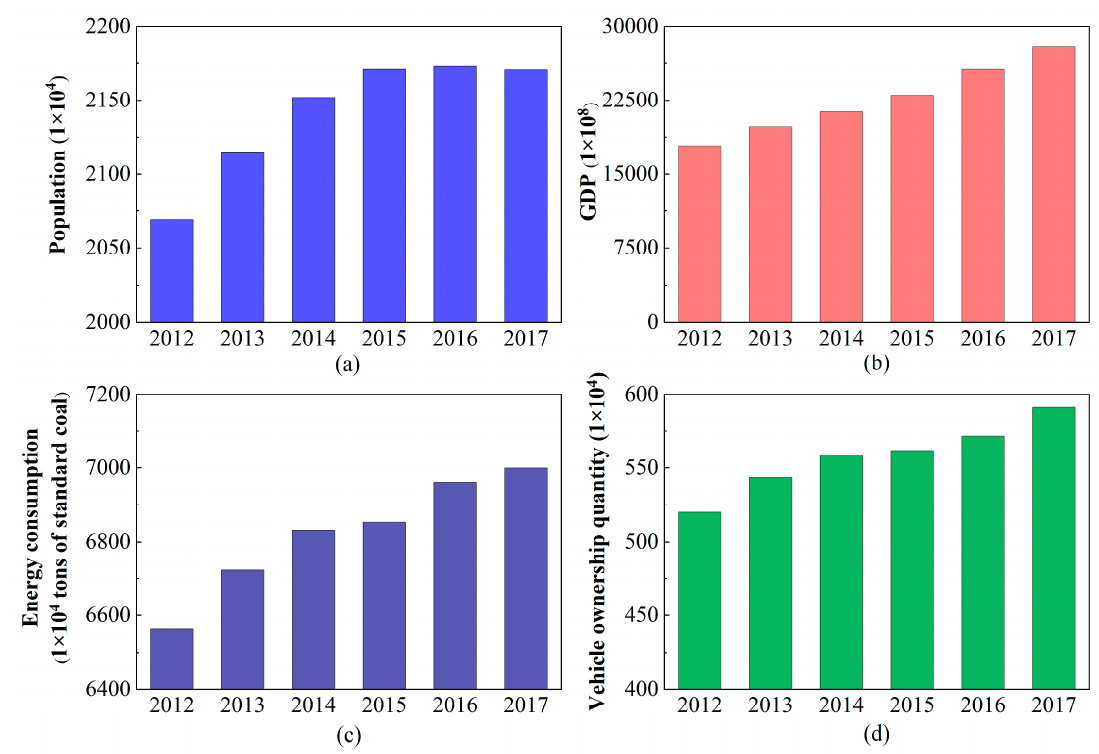
Figure 2. Population ( a ), GDP ( b ), energy consumption ( c ) and vehicle ownership quantity ( d ) changes in Beijing from 2012 to 2017.